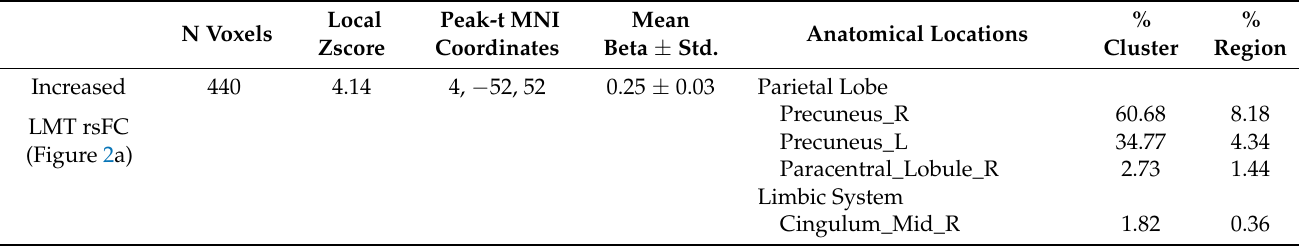
Figure 3. Functional connectivity between the LMT and precuneus, RFE and frontal, and LMT and temporal regions at baseline and follow-up.